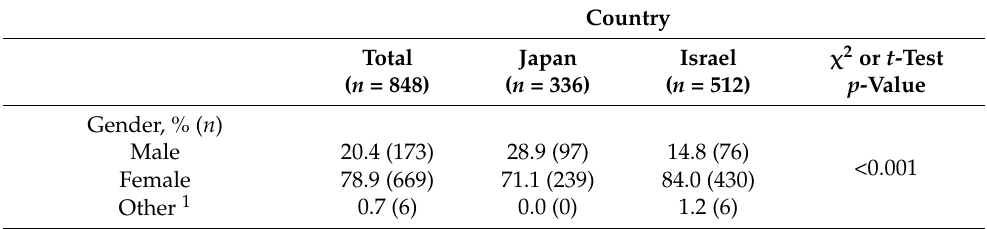
Table 1. Demographic